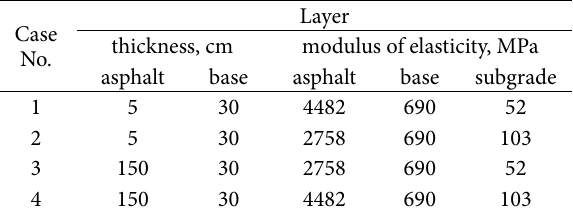
fig. 4. Decimated vertical tire contact stresses for 11 R 22.5 at